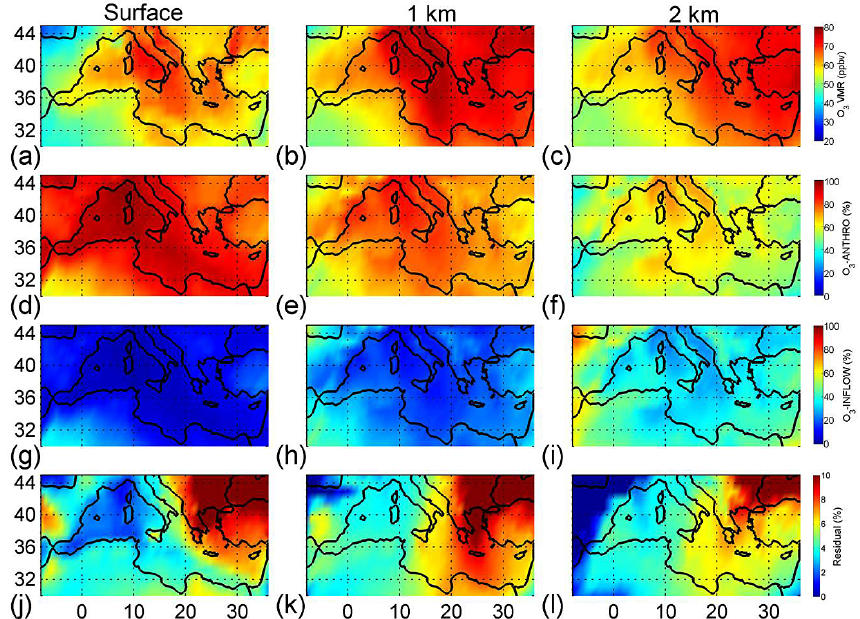
Figure 8. WRF-Chem spatial distributions of (a–c) O 3 mixing ratios (ppbv), (d–f) O 3 anthropogenic tracer relative contributions (%), (g–i) O 3 inflow tracer relative contribution, and (j–l) the residual (100% − (O 3-ANTHRO % + O 3-INFLOW %)) averaged over the period JJA 2010 at the surface and 1 and 2km. Note that the color bar for the residual plots is